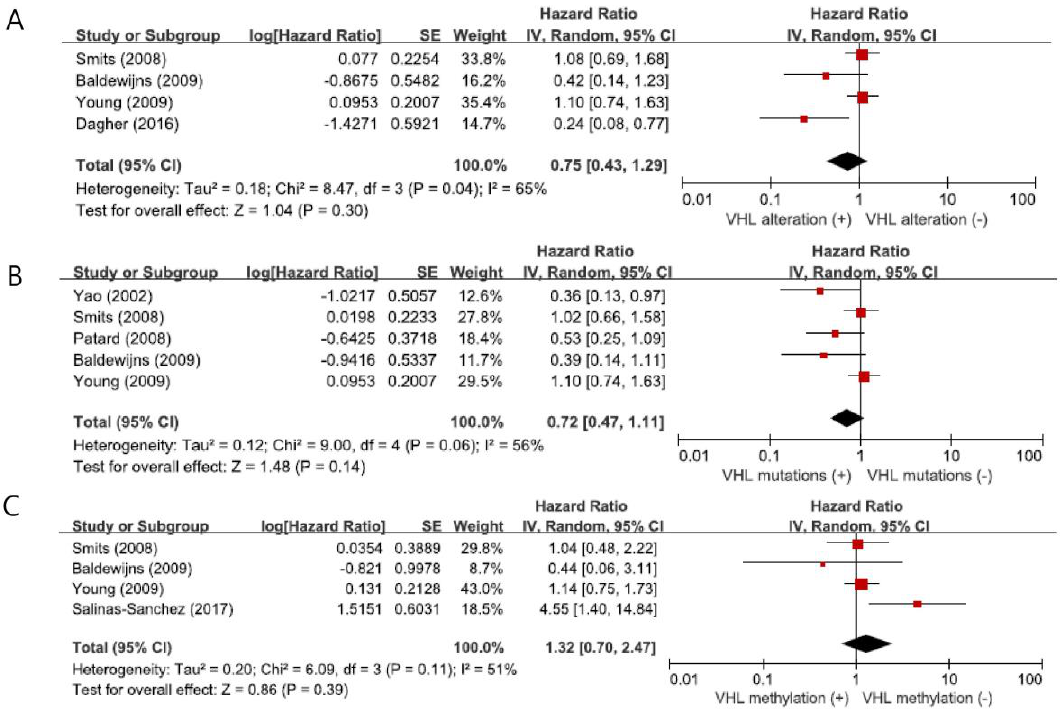
Figure 3. Forest plots for the association of VHL variations with overall survival. ( A ) VHL alteration. ( B ) VHL mutations. ( C ) VHL methylation.